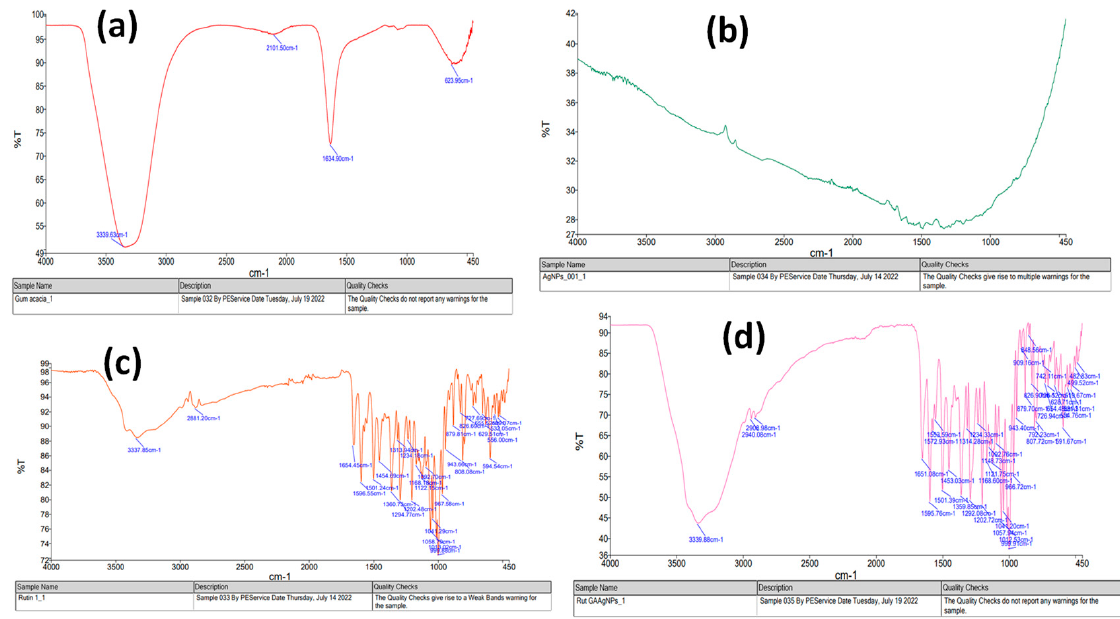
Figure 2. FTIR of ( a ) Gum-acacia; ( b ) Silver nanoparticles; ( c ) Rutin; ( d ) Rutin-SNPs .